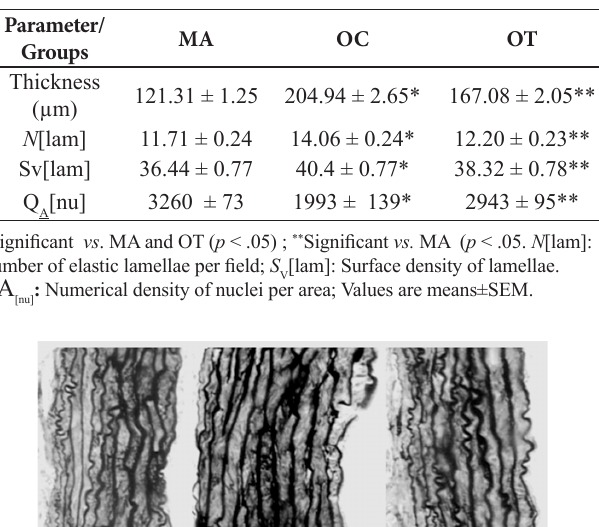
Table 2. Aortic structure of the MA, OC and OT groups of rats during the 4 month training period.